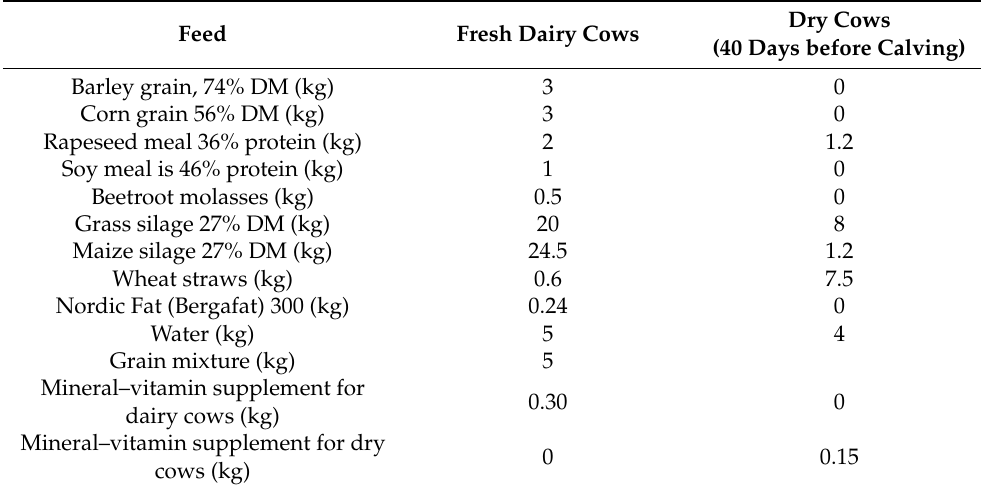
Table 1. Components of the total mix ration (TMR).